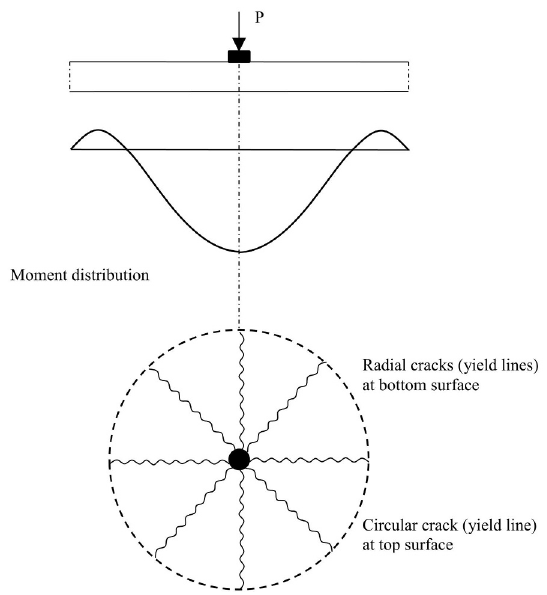
Figure 1. Distribution of bending moments and formation of cracks (yield lines).